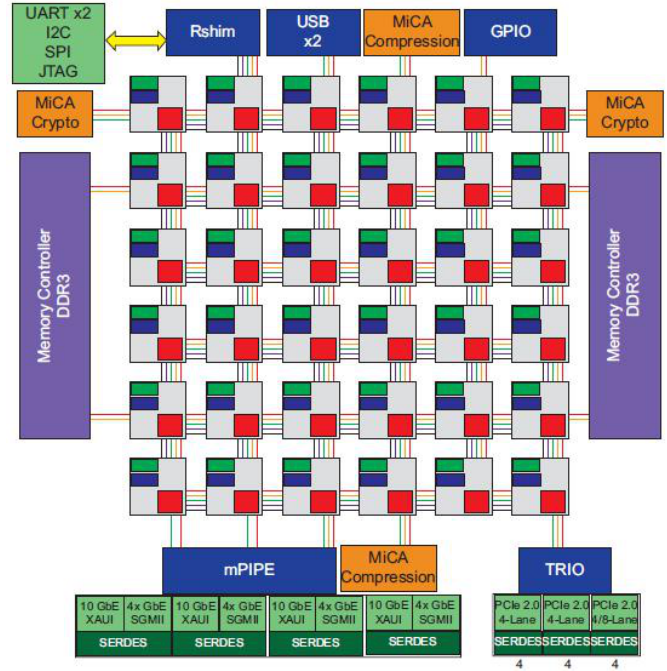
Figure 1. Overview of the TILEGX36